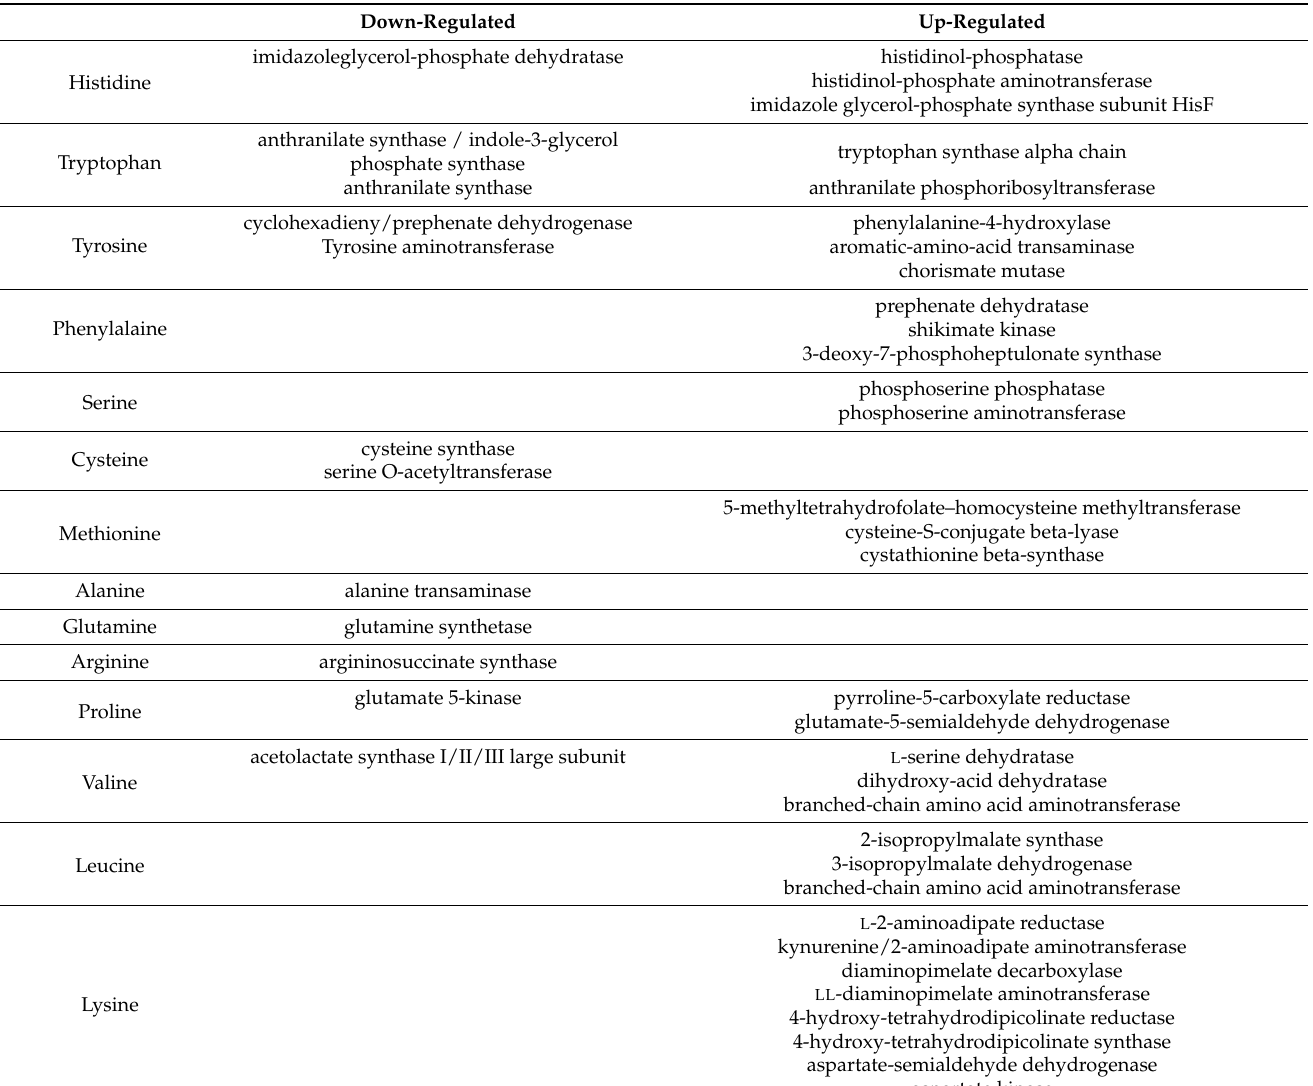
Table A7. Main DEGs in amino acid biosynthesis pathways (gall vs.